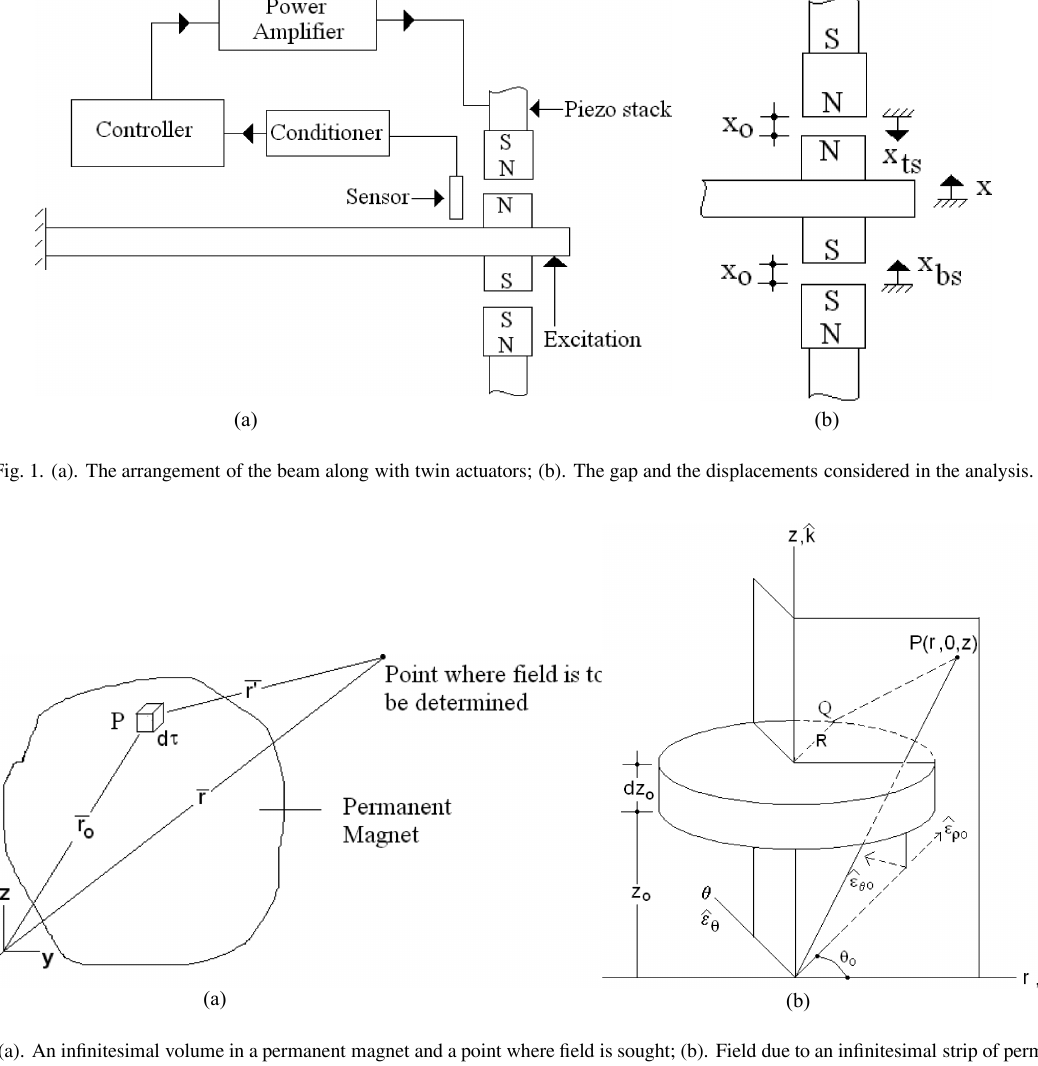
Fig. 2. (a). An in fi nitesimal volume in a permanent magnet and a point where fi eld is sought; (b). Field due to an in fi nitesimal strip of permanent